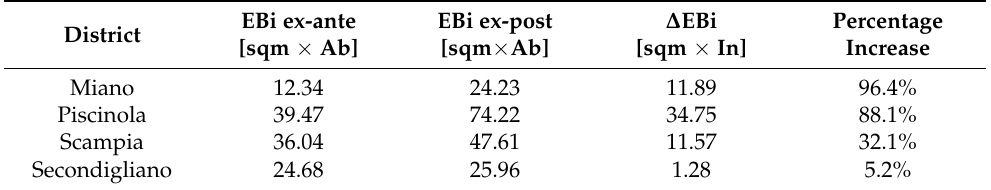
Table 6. Percentage increase in ecologically efficient areas.